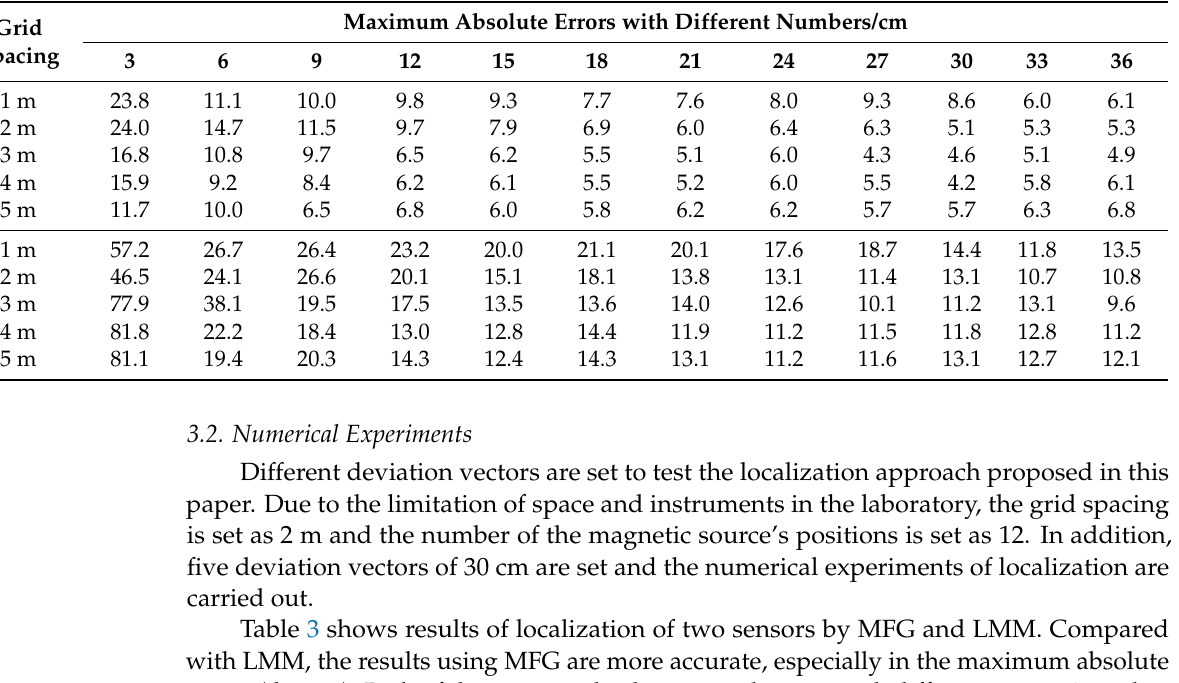
Table 2. Maximum absolute errors with different